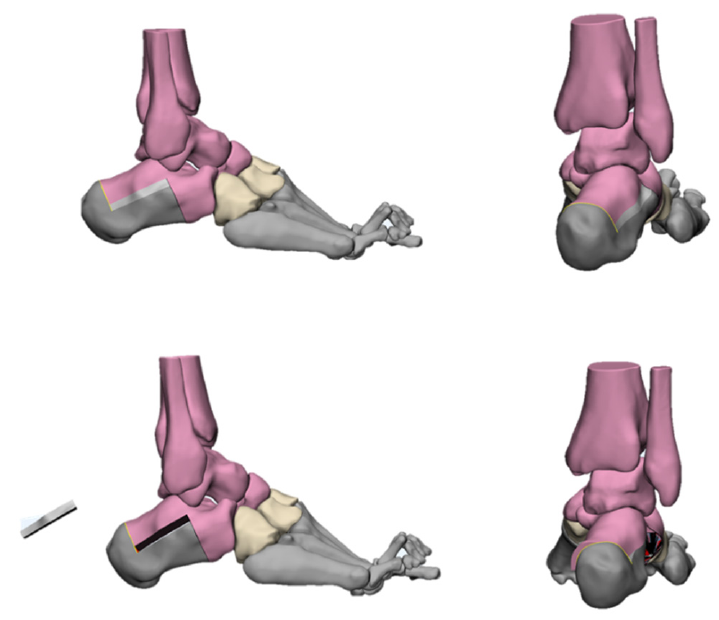
Figure 17. The Z-shaped calcaneus Osteotomy. Mixed Cavus